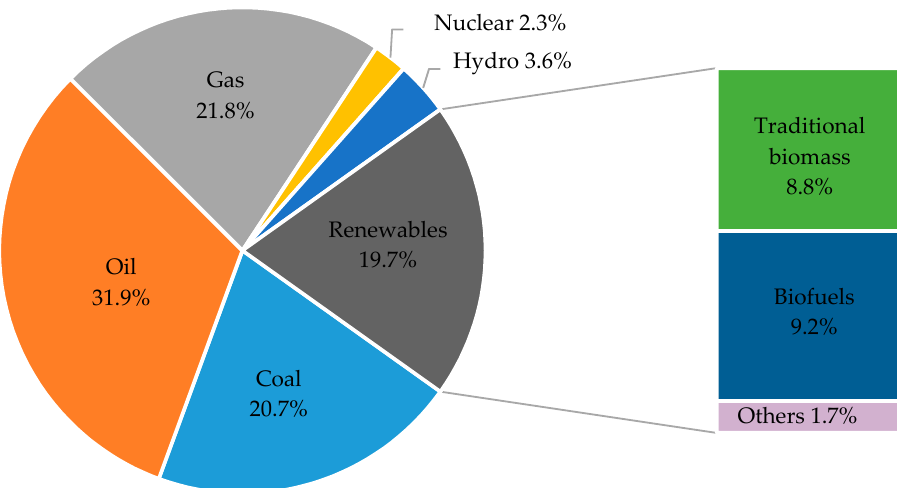
Figure 2. Total global primary energy demand by source (others includes wind, solar and geothermal energy) [11].